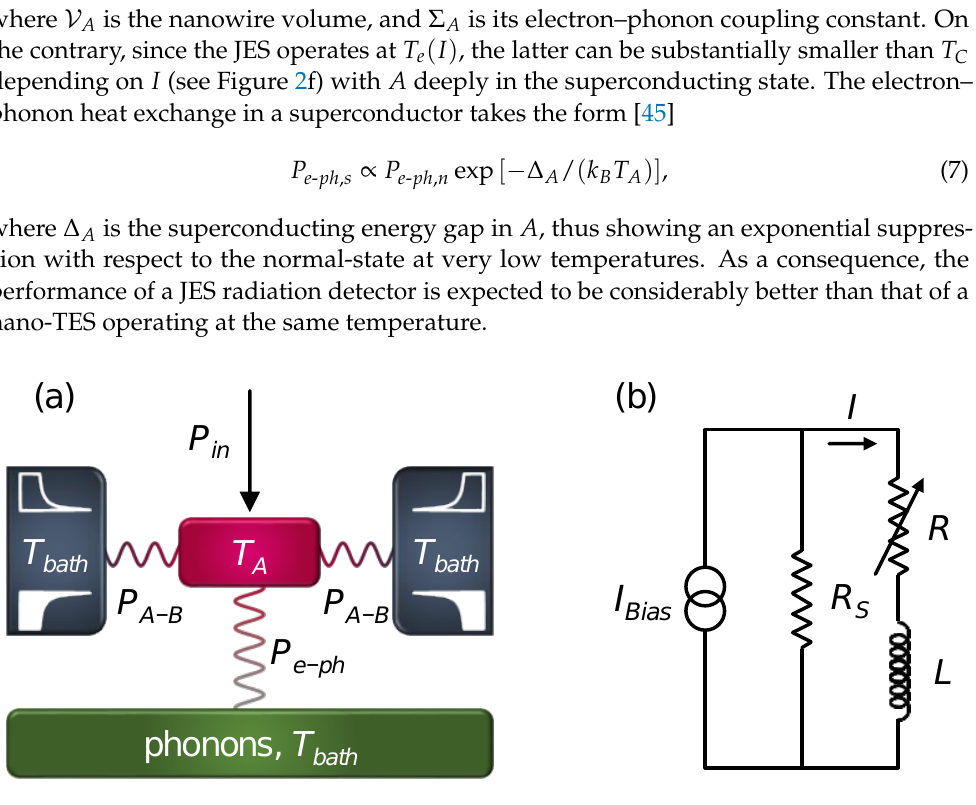
Figure 3. General thermal and electrical model of the nano-trasition edge sensor (TES) and Josephson escape sensor (JES). ( a ) Thermal model of the nano-sensors where the main thermal exchange channels are shown. P in is the power coming from the incoming radiation, P e − ph is the heat exchanged between electrons at T A (violet) and lattice phonons at T bath (green), and P A − B is the heat current flowing towards the superconducting electrodes at T bath (blue). ( b ) Schematic representation of a typical biasing circuit for the sensors. The parallel connection of the sensor ( R ) and the shunt resistor ( R S ) is biased by the current I Bias . The role of R S is to limit the Joule overheating of the active region when transitioning to the normal-state. The I variations are measured thank to the inductance L , for instance by a SQUID